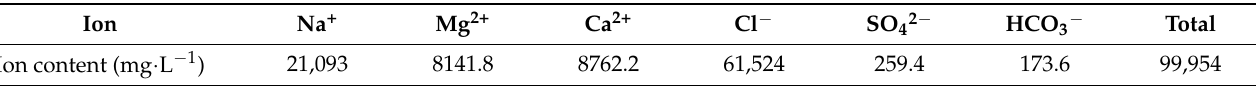
Table 3. Compositions of the hard